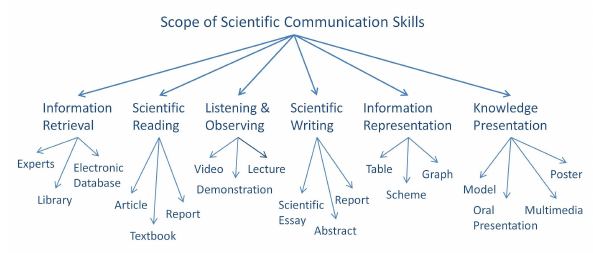
Fig. 3. Components of effective scientific communication. Redrawn from Spektor-Levy et al.